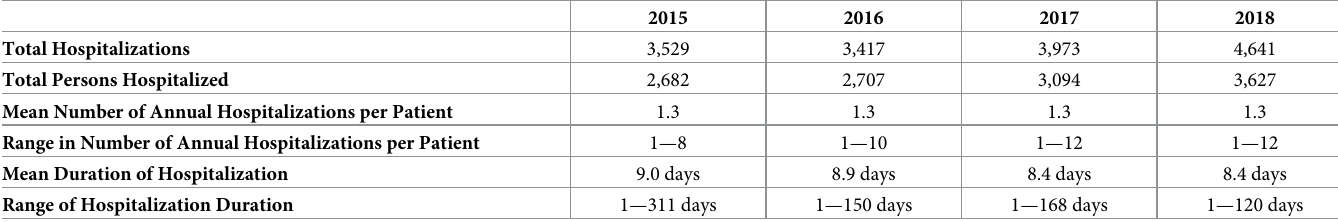
Table 1. Hospitalization of IESS-associated patients with